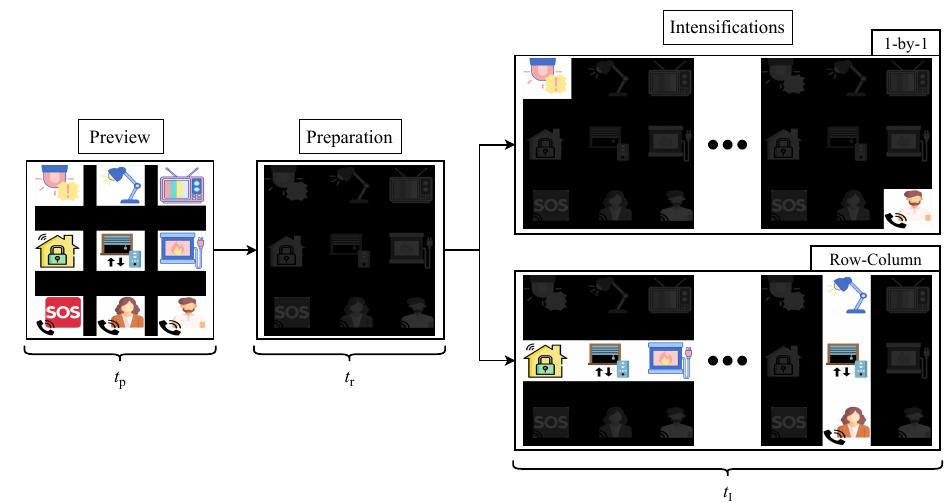
Figure 4. Sequence of steps in the two stimulation